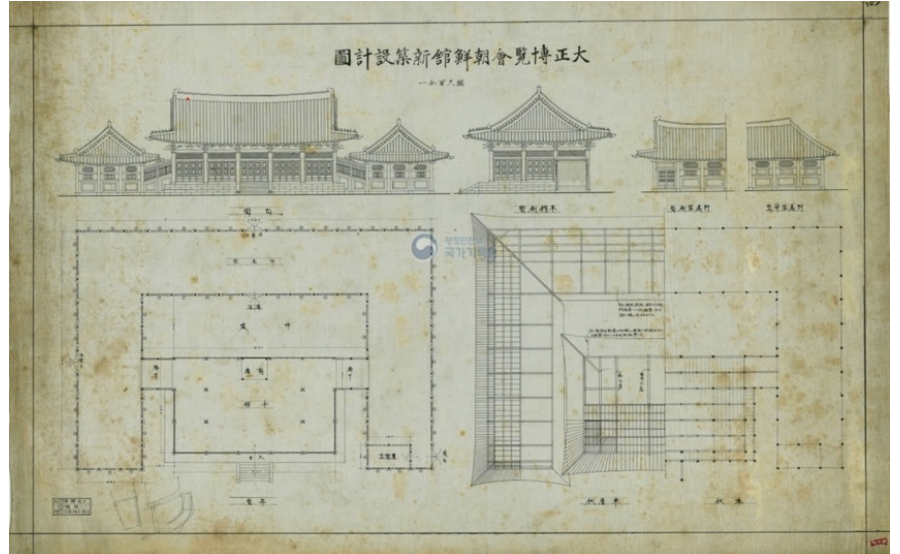
Figure 2. Overall Plan and Section Drawings of the Korea Pavilion at the 1914 Tokyo Taisho Expo (Source: National Archives of Korea) [5].